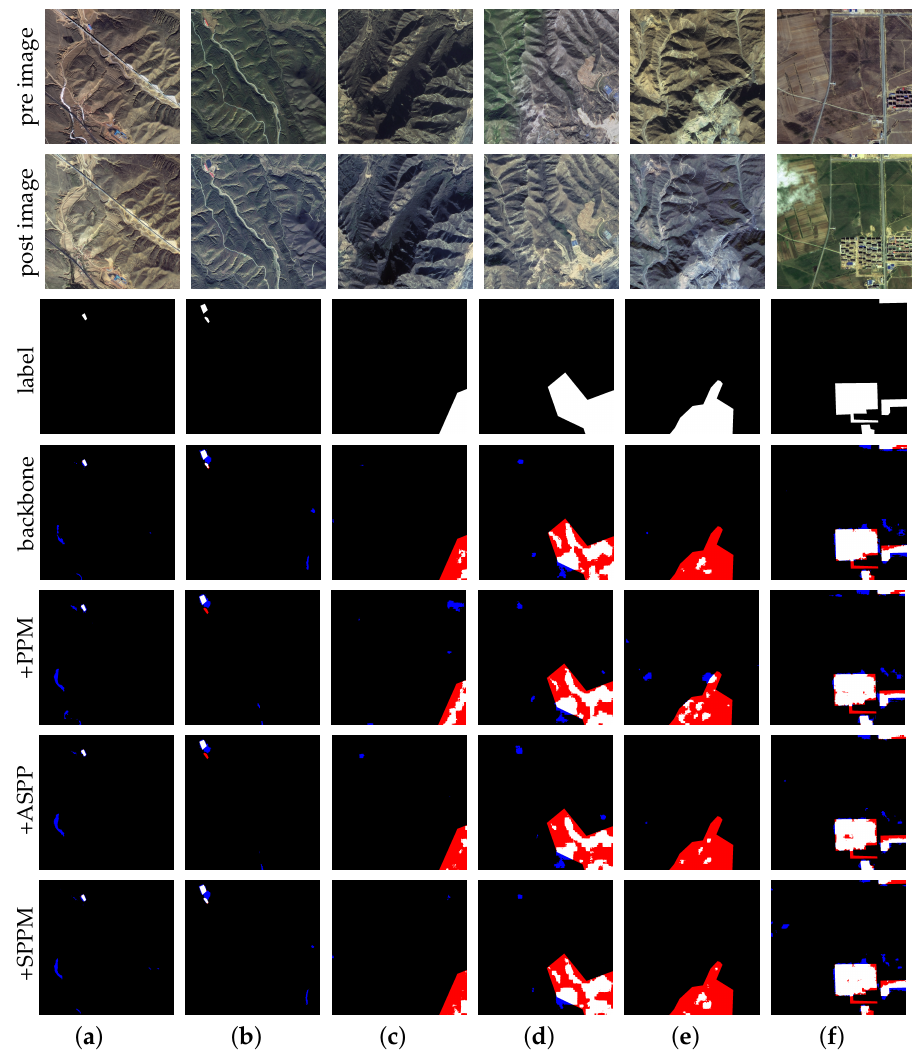
Figure 5. Six groups of images using different pooling methods. ( a ) Buildings in Eco-redline areas. ( b ) Buildings in Eco-redline areas. ( c ) Mines in Eco-redline areas. ( d ) Mines in Eco-redline areas. ( e ) Mines in Eco-redline areas. ( f ) Buildings in rural